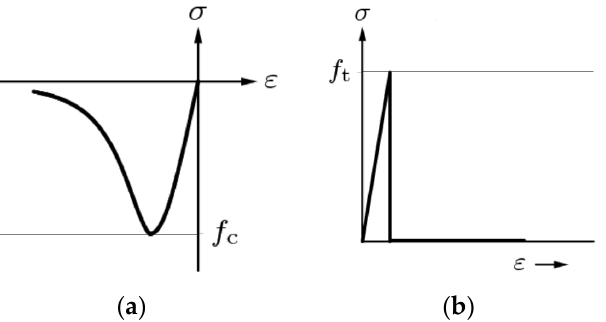
Figure 7. Concrete stress–strain curves: ( a ) The stress–strain relationship of compressive concrete (Thorenfeldt) [34]; ( b ) the stress–strain relationship of tensile concrete (brittle) [35]. An interface for bond evaluation is provided between concrete layers. Interface type —3D surface interface, as shown in Figure 8. Two types of interface stiffness modulus are provided. Normal stiffness modulus is equal to concrete modulus of elasticity E = 33 GPa. Shear stiffness modulus is equal to G = 13 GPa during stage 1. At the start of stage 3, when bond between layers becomes partially rigid and layers begin to slip, shear stiffness modulus is equal to G = 2 GPa.